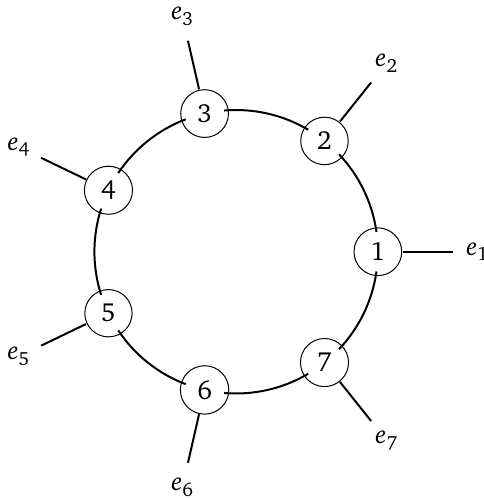
} and tensors { i } i